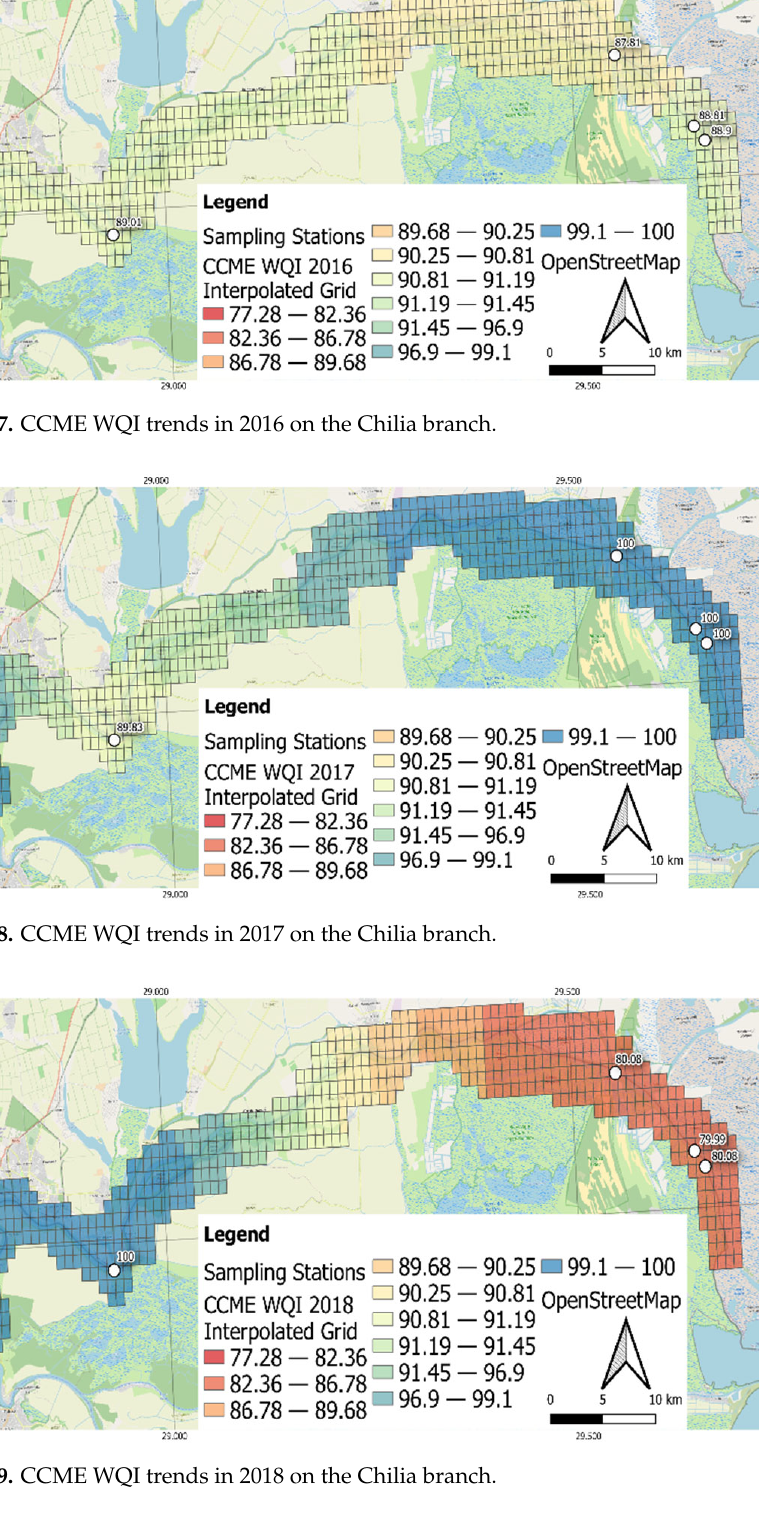
Figure 9. CCME WQI trends in 2018 on the Chilia branch.